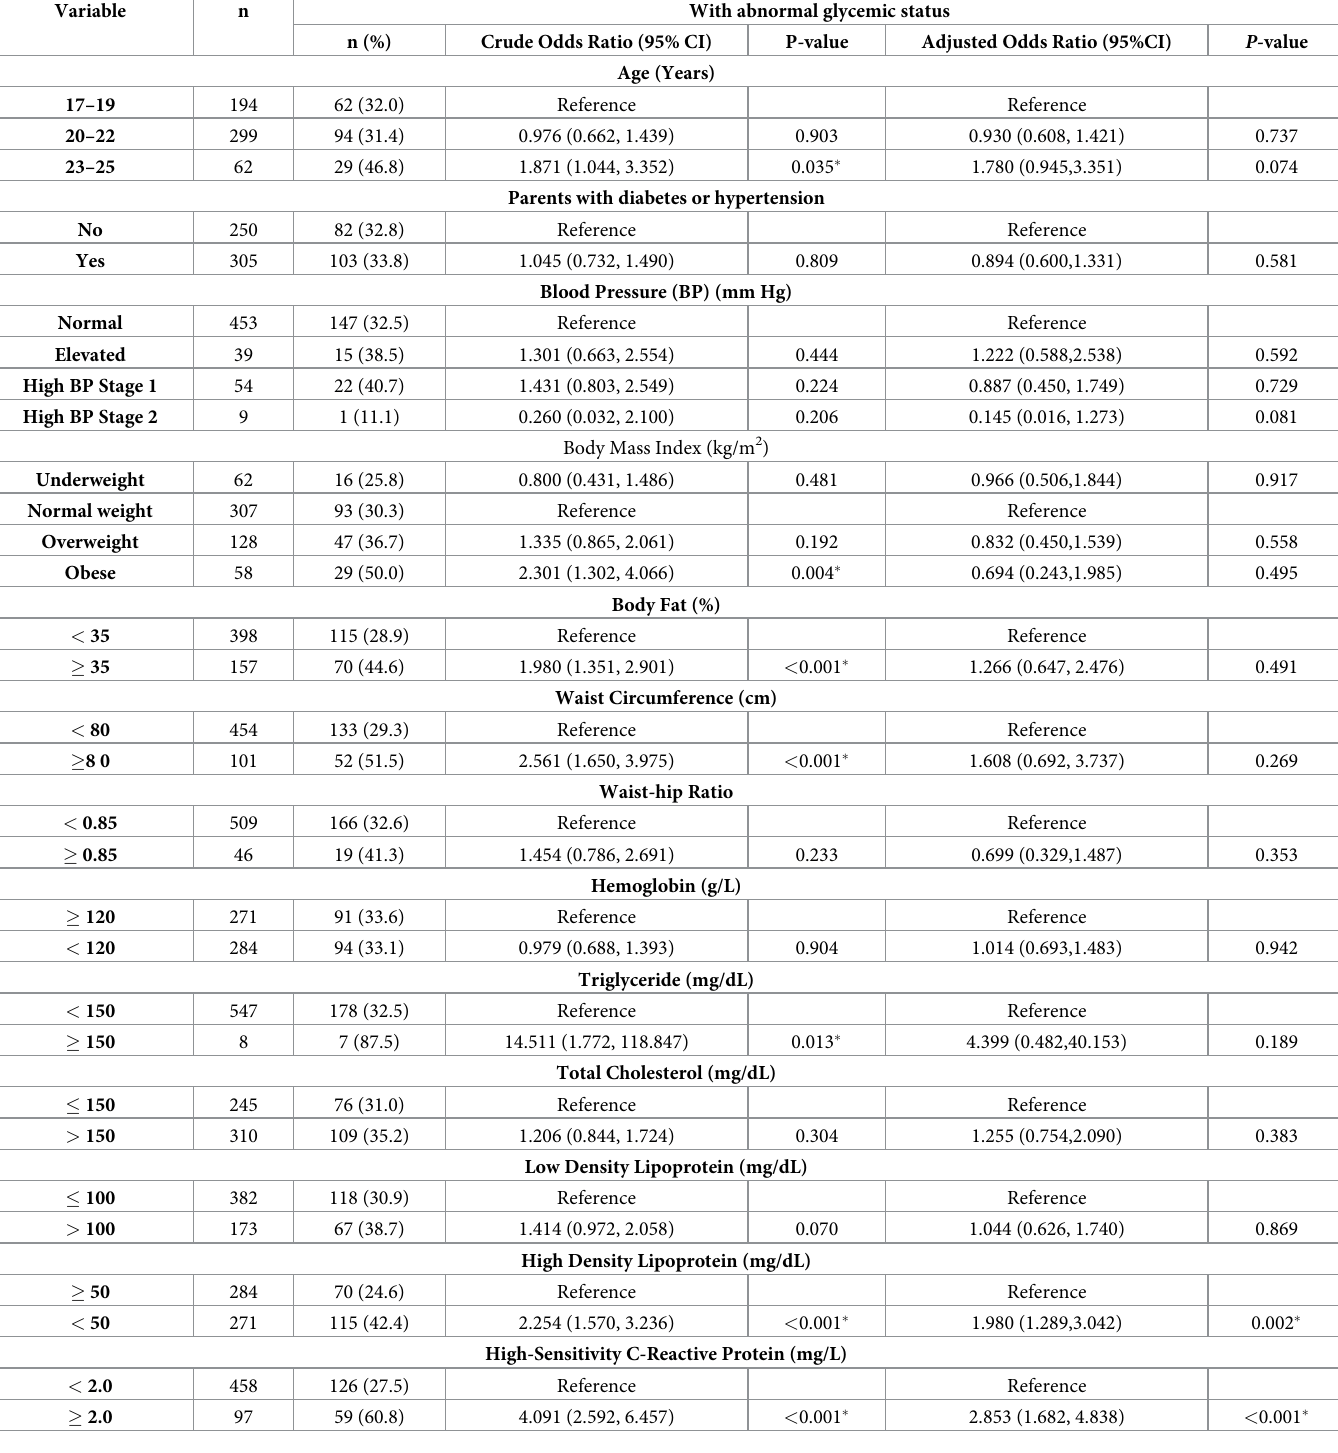
Table 3. Risk factors for abnormal glycemic status based on FPG and HbA1c.